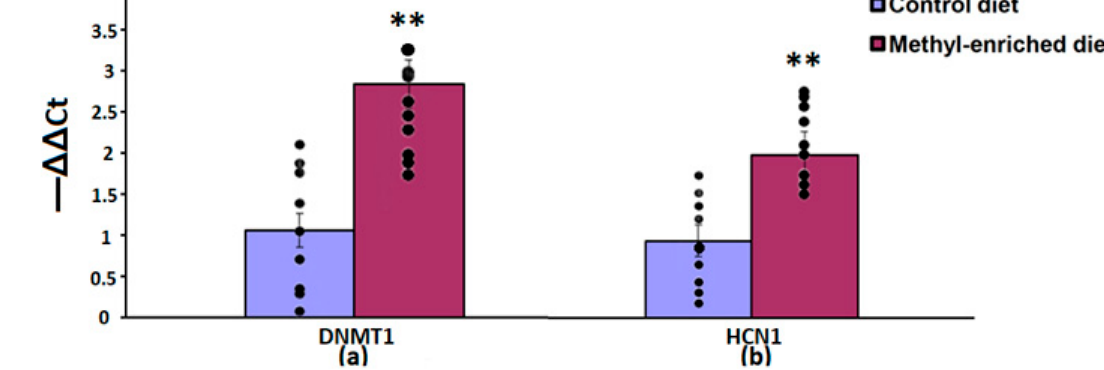
Figure 5. The mRNA expression levels of DNMT1 ( a ) and HCN1 ( b ) genes in the hippocampus in adult offspring of WAG/Rij rats born to mothers fed a methyl-enriched or control diet. Expression of the DNMT1 and HCN1 mRNA were determined by real-time qPCR in 9 pairs of tissue samples from the control ( n = 10 rats) and experimental ( n = 10 rats) group of animals. Data are the mean ± S.E.M. The individual data points are displayed in bar graphs to show within-group variability. **— p < 0.01 compared with the corresponding values in the control